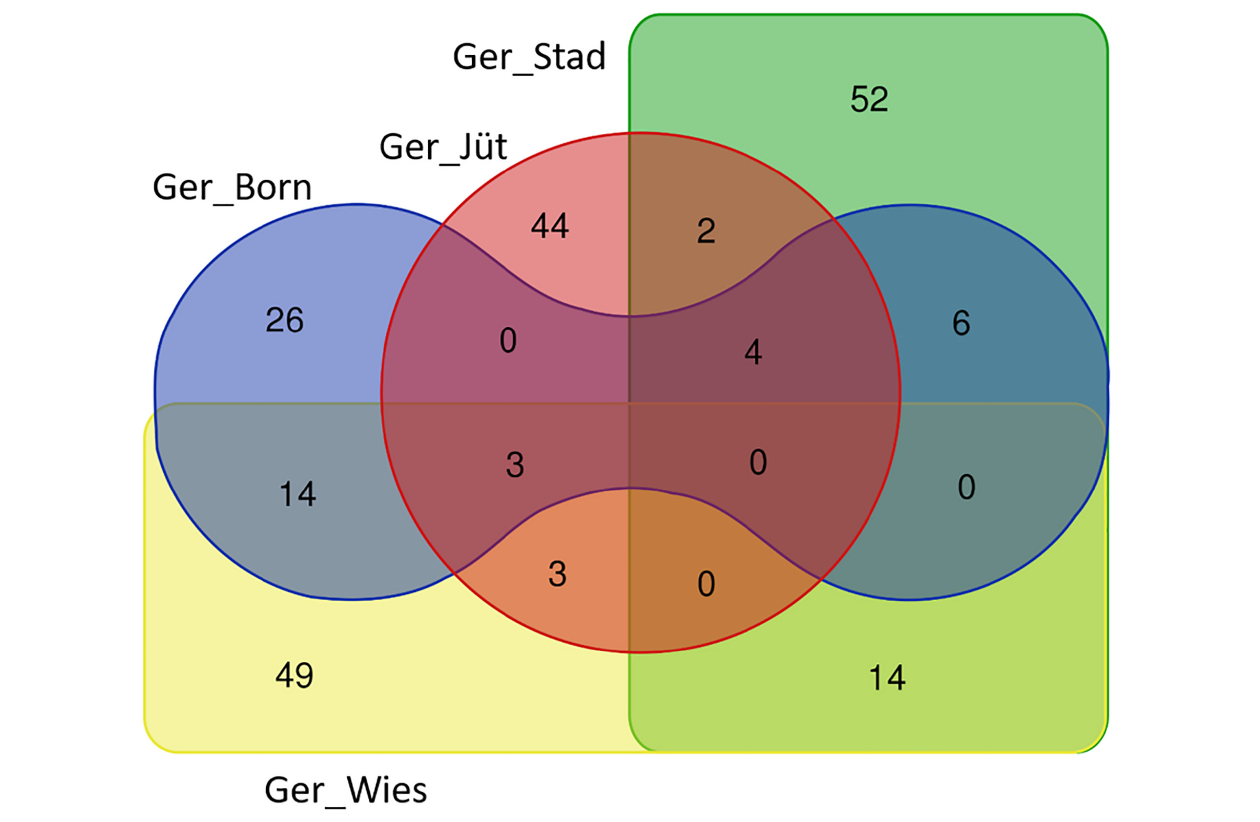
FIGURE 9 | Venn diagram reporting the number of common and unique genes present in overlapping ROH regions with the highest frequency SNPs in different buffalo populations from Germany (gene names are referred by Table 6 ).